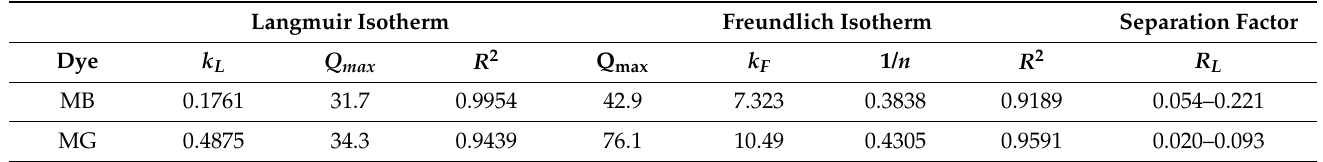
Table 3. Parameters for the Langmuir isotherm, Freundlich isotherm, and separation factor for MB and MG adsorption.